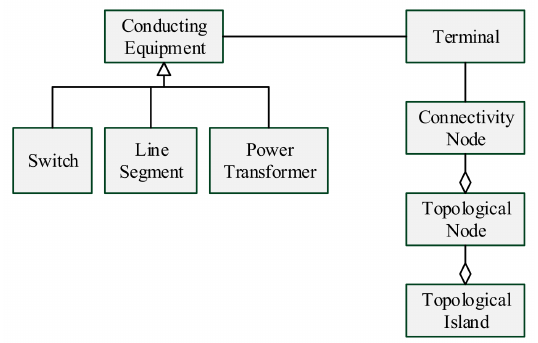
Figure 3. Topology